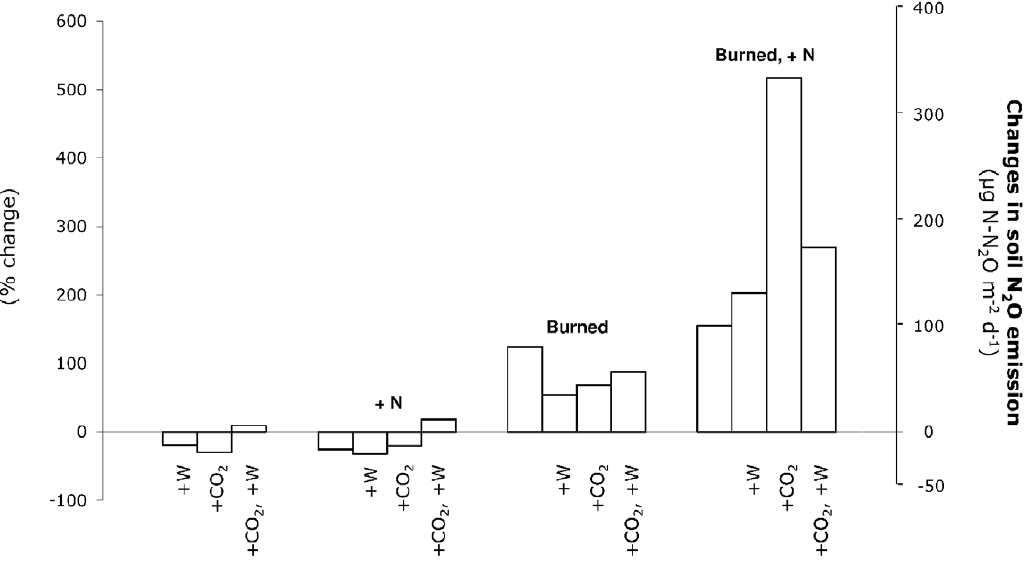
Figure 2. Treatment effects on soil N 2 O emission rates. Treatments are increased precipitation ( + W), elevated CO 2 ( + CO 2 ), enhanced N supply ( + N), burn (Burned), and all their combinations. Treatment effects were calculated across the five measurement dates (i.e. 9, 15, 19, 21 and 33 months after fire) as: % effect=100 6 [treatment 2 control]/[control]. In the control treatment, all factors are ambient. Changes in soil N 2 O emission rates in each treatment combination relative to the control treatment are also indicated. In the control treatment, soil N 2 O emission rates were 65 6 103 m g N-N 2 O m 2 2 d 2 1 (values indicate mean 6 pooled standard error; n=6 6 5 sampling dates).